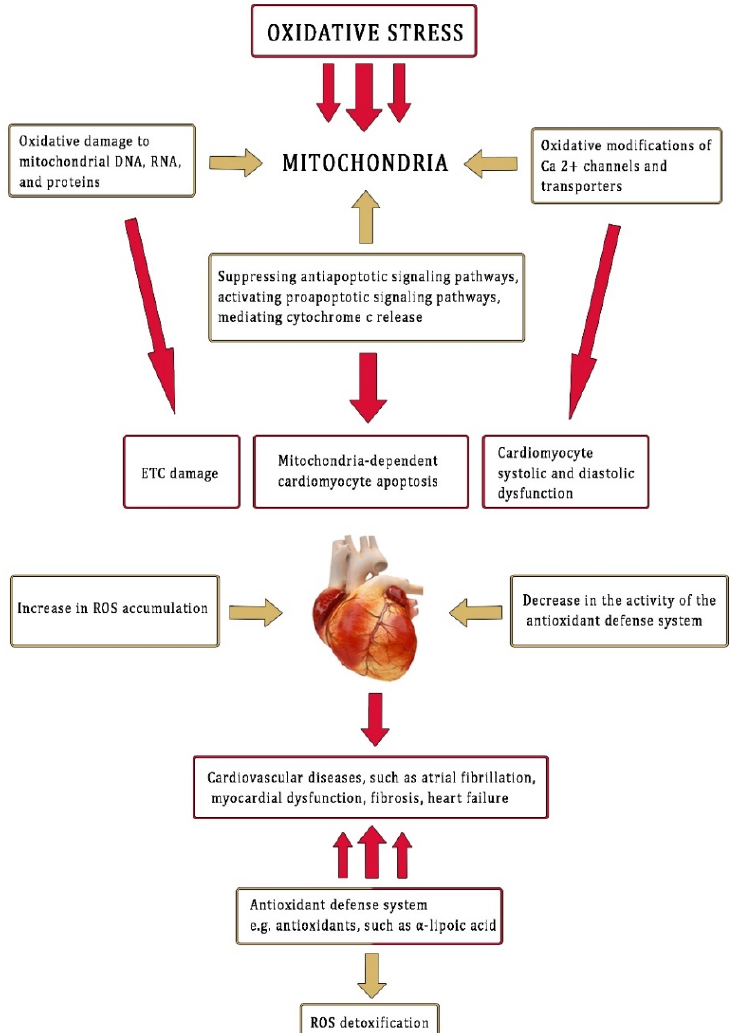
Figure 7. Effect of oxidative stress on cardiac damage. Adapted with permission from ref. [3]. Copyright 2015 Beata Skibska and Anna Goraca.